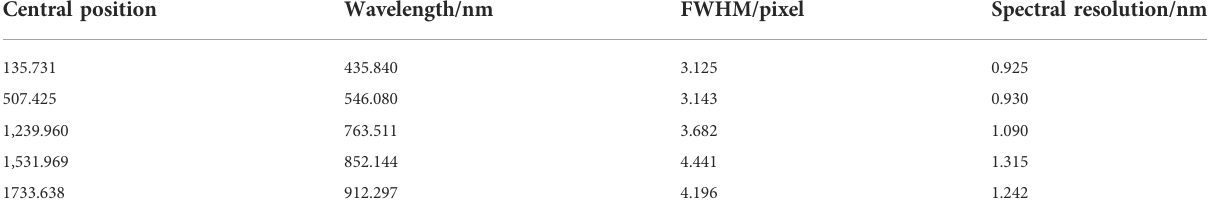
TABLE 3 Calibration result of the